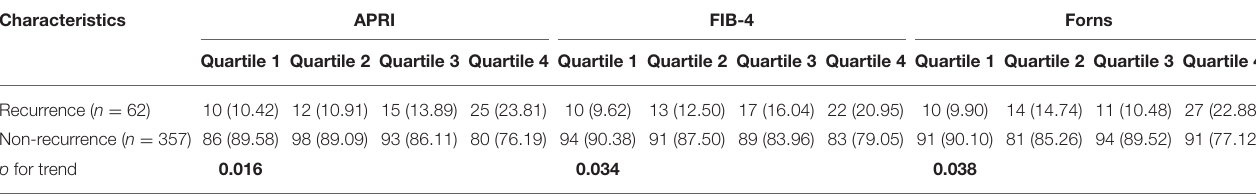
TABLE 4 | Trends in the prevalence of CSDH recurrence of the quartiles of liver fibrosis scores.